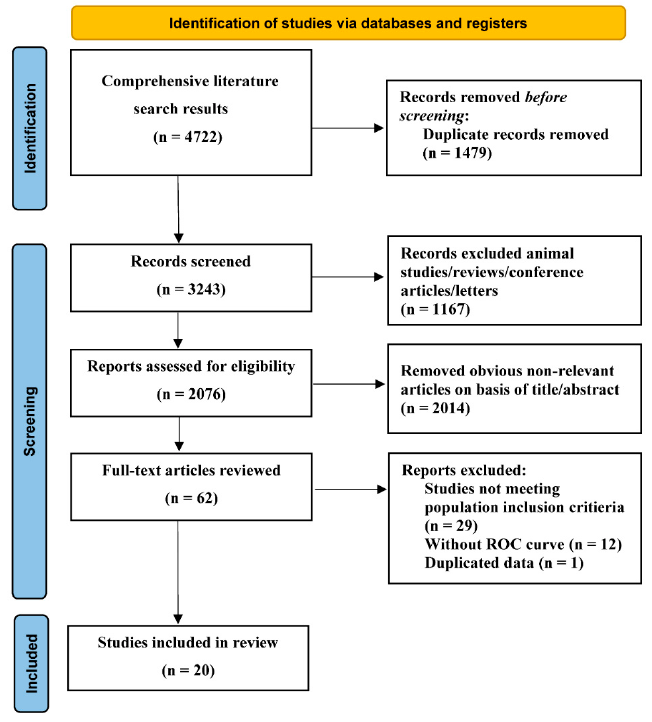
Figure 1. Flow graph of the literature search and selection.